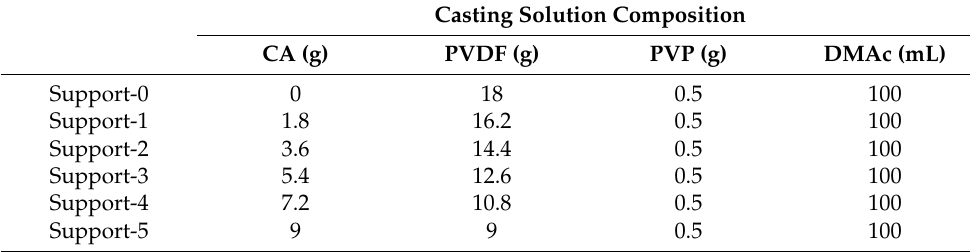
Table 1. The composition of the dope